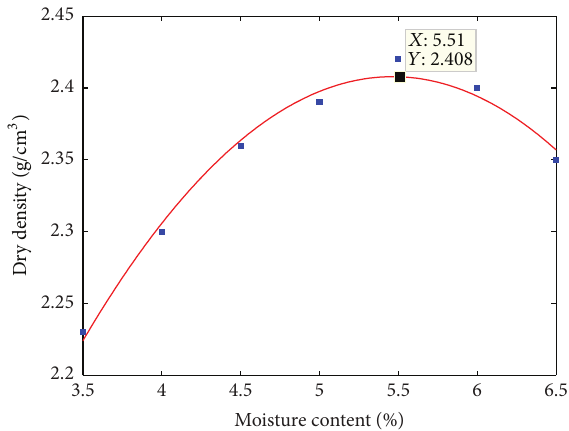
Figure 1: Relationship between moisture content and dry density.